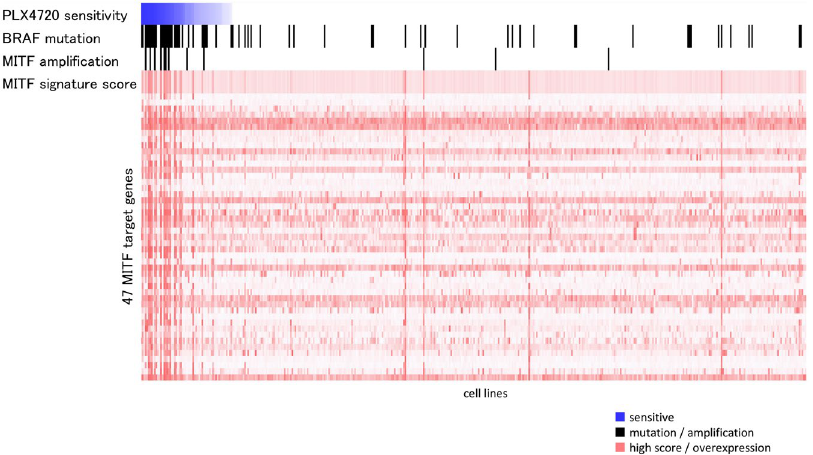
Figure 4. MITF-BRAF in the input data. Correlation between the PLX4720 sensitivity profile and alteration of the BRAF/MITF pathway in the JNMF input set. The x-axis shows cell lines according to their PLX4720 sensitivity. The y-axis represents the PLX4720 sensitivity profiles, BRAF mutation, MITF amplification, MITF activation signature, and expression profiles of the MITF target genes. The score of the MITF activation signature is defined as the averaged and normalized expression profiles of the MITF target genes. JNMF selected these features as belonging to the BRAF mutation and PLX4720